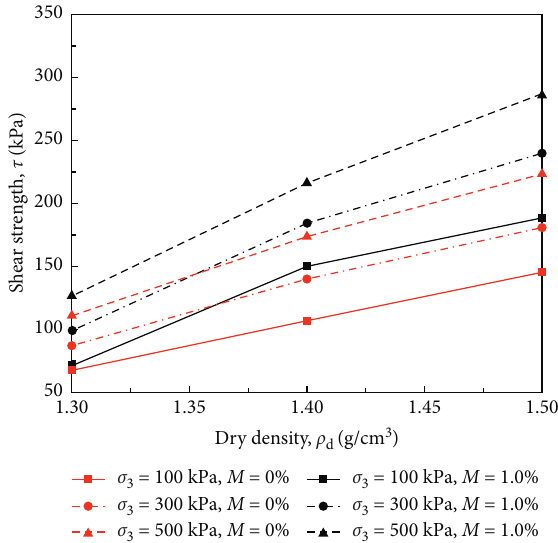
Figure 6: Effect of dry density on shear strength.